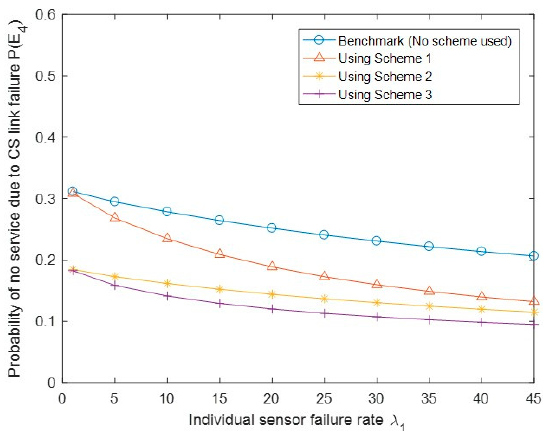
Figure 14. Performance comparison of the probability of no service due to CS link failure P ( E 4 ) under the benchmark and three API schemes.